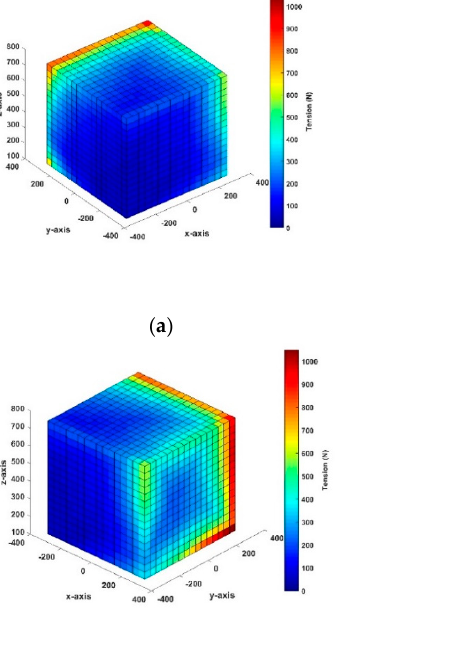
Figure 7. Overall workspace simulation at the acceleration of 10 m/s 2 : ( a ) front plane of the X –axis; ( b ) back plane of the X –axis; ( c ) front plane of the Y –axis; ( d ) back plane of the Y –axis.